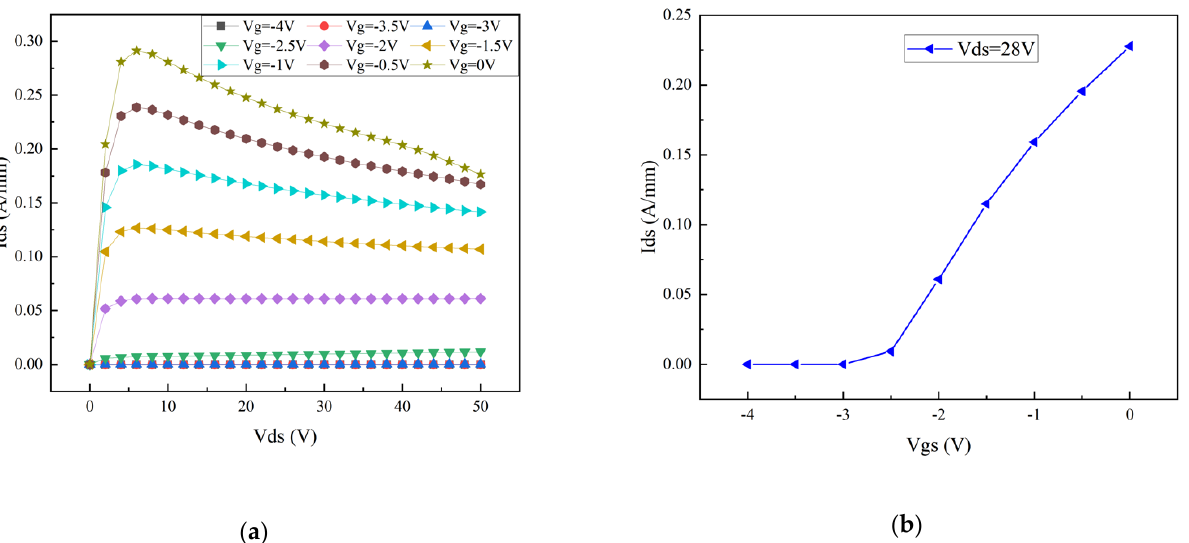
Figure 1. The characteristics of 0.25 μm GaN HEMT: ( a ) I – V curve of 0.25 μm GaN HEMT ; ( b ) transfer curve of 0.25 μm GaN HEMT.